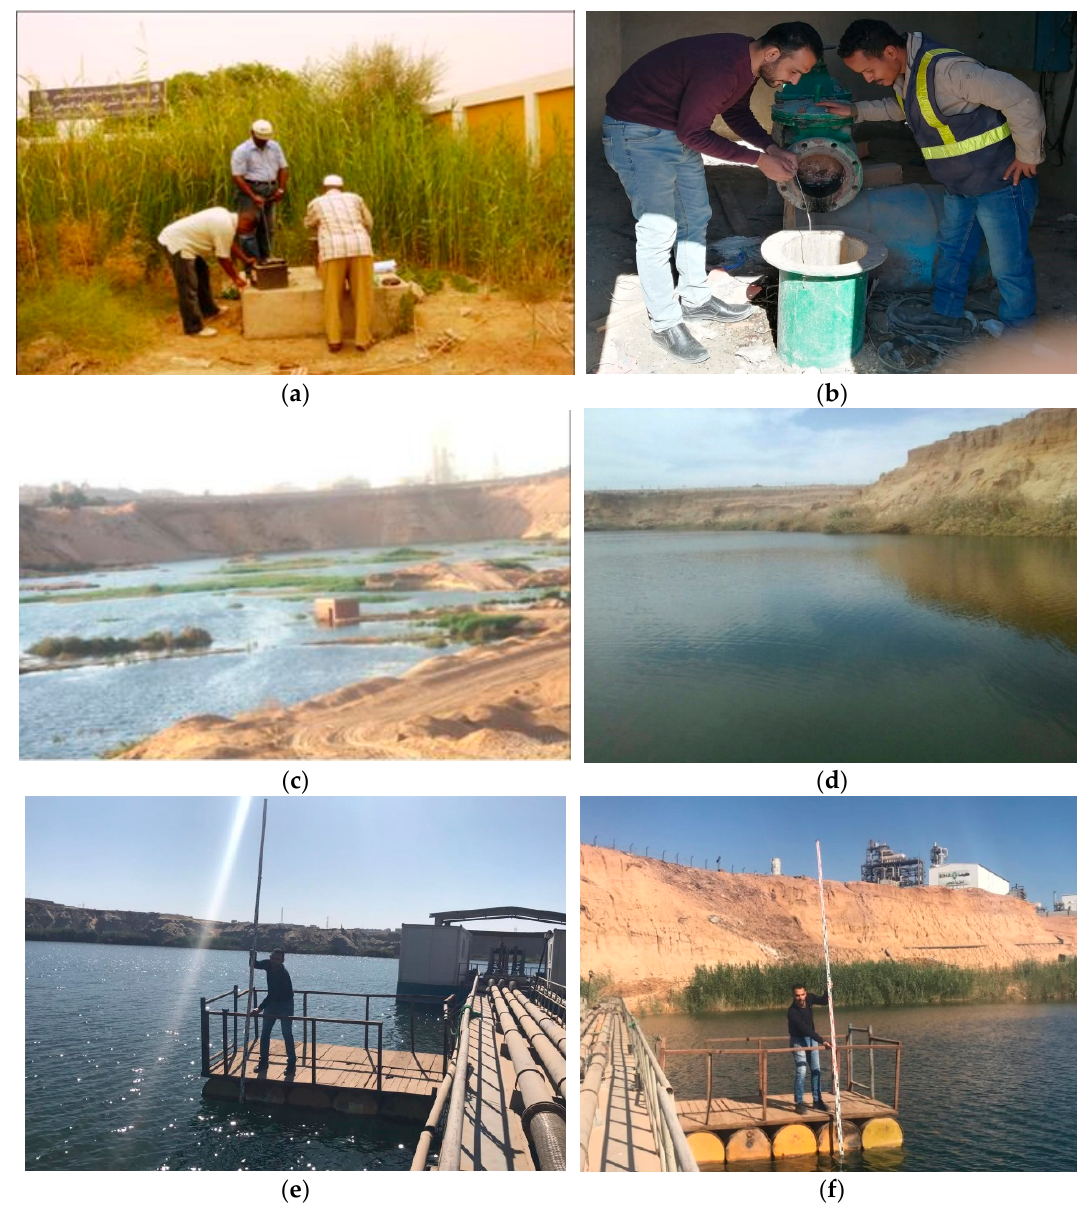
Figure 5. Field data collection and measurements: ( a ) El-Shallal wells; ( b ) Kima wells water levels measurement; ( c ) Kima Lake after 2009; ( d ) Kima Lake 2020; ( e ) and ( f ) Kima Lake measurement.